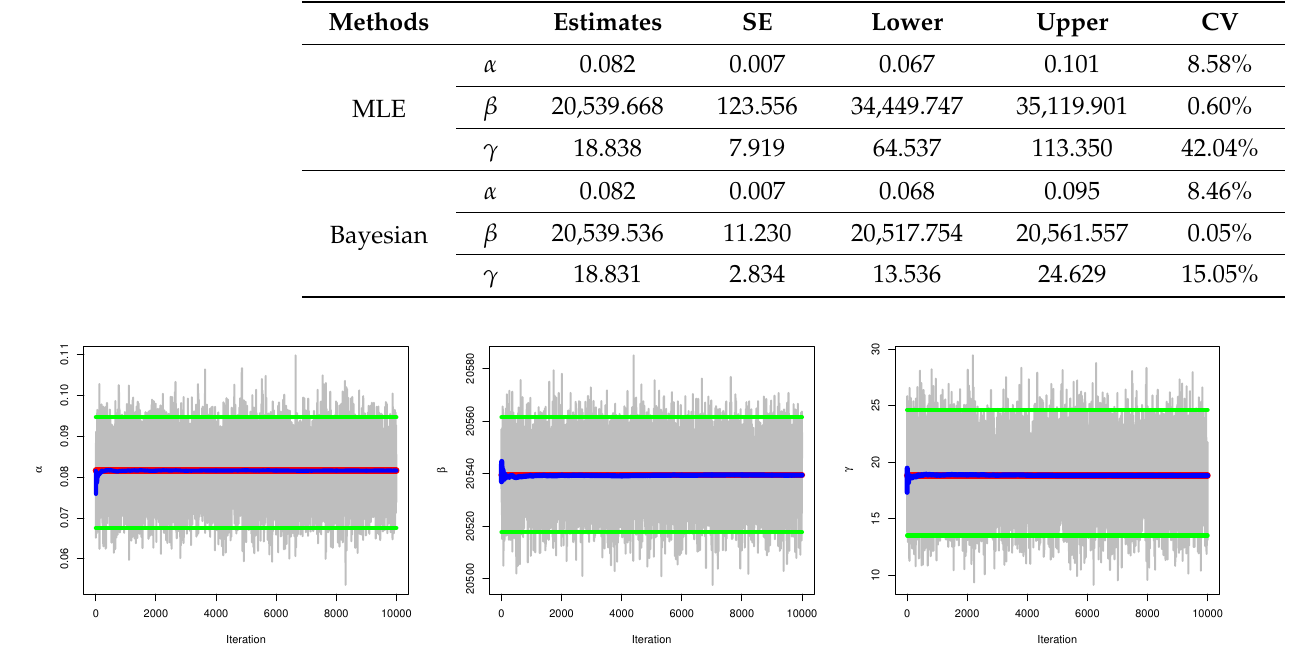
Figure 14. MLE of cdf, and pdf with empirical and histogram, QQ and PP of the KMWE model for food and drink wholesaling data. Table 10. Point and interval estimates and SE for parameters of KMWE distribution: data 2.